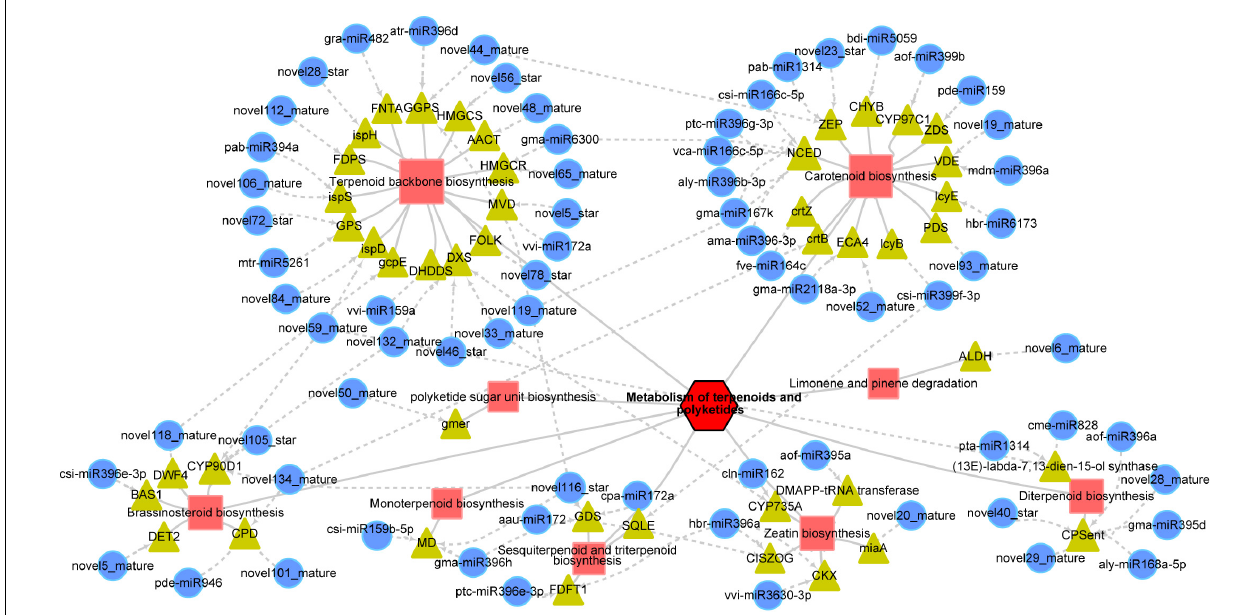
FIGURE 6 | MicroRNA regulatory network involved in the metabolism of terpenoids and polyketides. The red squares indicate metabolic pathways, the yellow triangles indicate genes, and the blue circles indicate miRNAs. The dotted lines with arrows indicate how the miRNAs regulate specific genes. The abbreviation of each gene is as follows: AACT , acetyl-CoA C-acetyltransferase; ALDH , aldehyde dehydrogenase; BAS1 , PHYB activation tagged suppressor 1; CHYB , beta-ring hydroxylase; CISZOG , cis -zeatin O -glucosyltransferase; CKX , cytokinin dehydrogenase; CPD , cytochrome P450 family 90 subfamily A polypeptide 1; CPSent , ent-copalyl diphosphate synthase; crtB , 15- cis -phytoene synthase; crtZ , beta-carotene 3-hydroxylase; CYP735A , cytokinin trans -hydroxylase; CYP90D1 , 3-epi-6-deoxocathasterone 23-monooxygenase; CYP97C1 , carotene epsilon-monooxygenase; DET2 , steroid 5-alpha-reductase; DHDDS , ditrans,polycis-polyprenyl diphosphate synthase; DMAPP-tRNA transferase , tRNA dimethylallyltransferase; DWF4 , steroid 22-alpha-hydroxylase; DXS , 1-deoxy- D -xylulose-5-phosphate synthase; ECA4 , Ca 2 + -transporting ATPase; FDFT1 , farnesyl-diphosphate farnesyltransferase; FDPS , farnesyl diphosphate synthase; FNTA , protein farnesyltransferase/geranylgeranyltransferase type-1 subunit alpha; FOLK , farnesol kinase; GDS , (–)-germacrene D synthase; gcpE , (E)-4-hydroxy-3-methylbut-2-enyl-diphosphate synthase; gmer , GDP-4-keto-6-deoxy- D -mannose-3,5-epimerase-4-reductase; GGPS , geranyl diphosphate synthase; HMGCR , hydroxymethylglutaryl-CoA reductase; HMGCS , hydroxymethylglutaryl-CoA synthase; ispD , 2-C-methyl- D -erythritol 4-phosphate cytidylyltransferase; ispH , 4-hydroxy-3-methylbut-2-en-1-yl diphosphate reductase; ispS , isoprene synthase; lcyB , lycopene beta-cyclase; lcyE , lycopene epsilon-cyclase; MD , (+)-neomenthol dehydrogenase; miaA , tRNA dimethylallyltransferase; MVD , diphosphomevalonate decarboxylase; NCED , 9- cis -epoxycarotenoid dioxygenase; PDS , 15- cis -phytoene desaturase; GPS , geranyl-diphosphate specific/all- trans -non-aprenyl-diphosphate synthase; SQLE , squalene monooxygenase; VDE , violaxanthin de-epoxidase; ZDS , zeta-carotene desaturase; ZEP , zeaxanthin epoxidase.